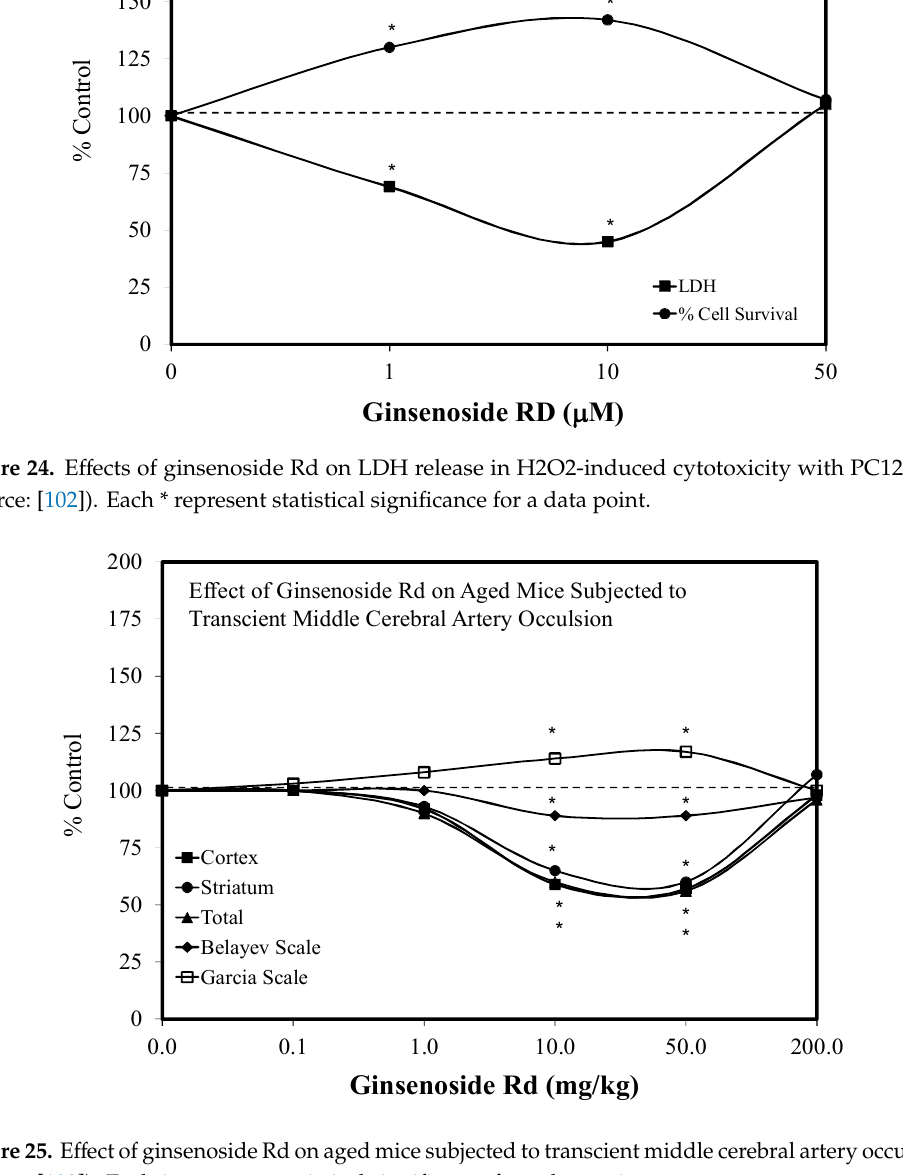
Figure 25. Effect of ginsenoside Rd on aged mice subjected to transcient middle cerebral artery occulsion (source: [103]). Each * represent statistical significance for a data point.